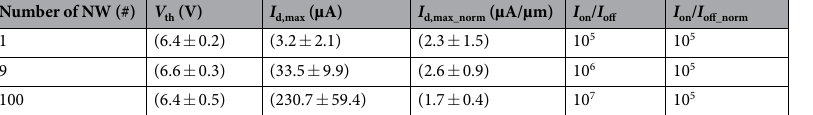
Number of NW (#) V th (V) I d,max ( µ A) I d,max_norm ( µ A/ µ m) I on / I off